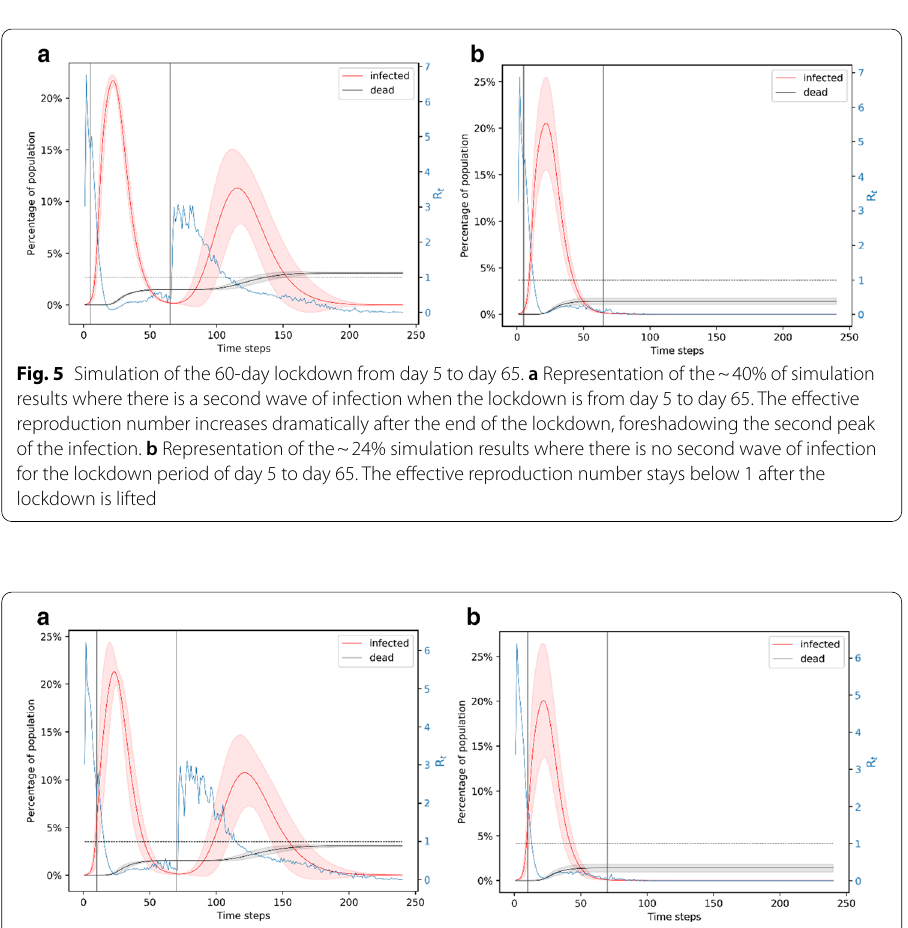
Fig. 6 Simulation of the 60-day lockdown from day 10 to day 70. a Representation of the ~ 33% of simulations that have a second wave of infection for the day 10 to day 70 lockdown. Similar to the day 5 to day 65 lockdown scenario, there is a dramatic peak in the reproduction number after the lockdown is lifted on day 70, foreshadowing a second wave of infection. b Representation of the ~ 39% of simulations that have only one wave of infection for the day 10 to day 70